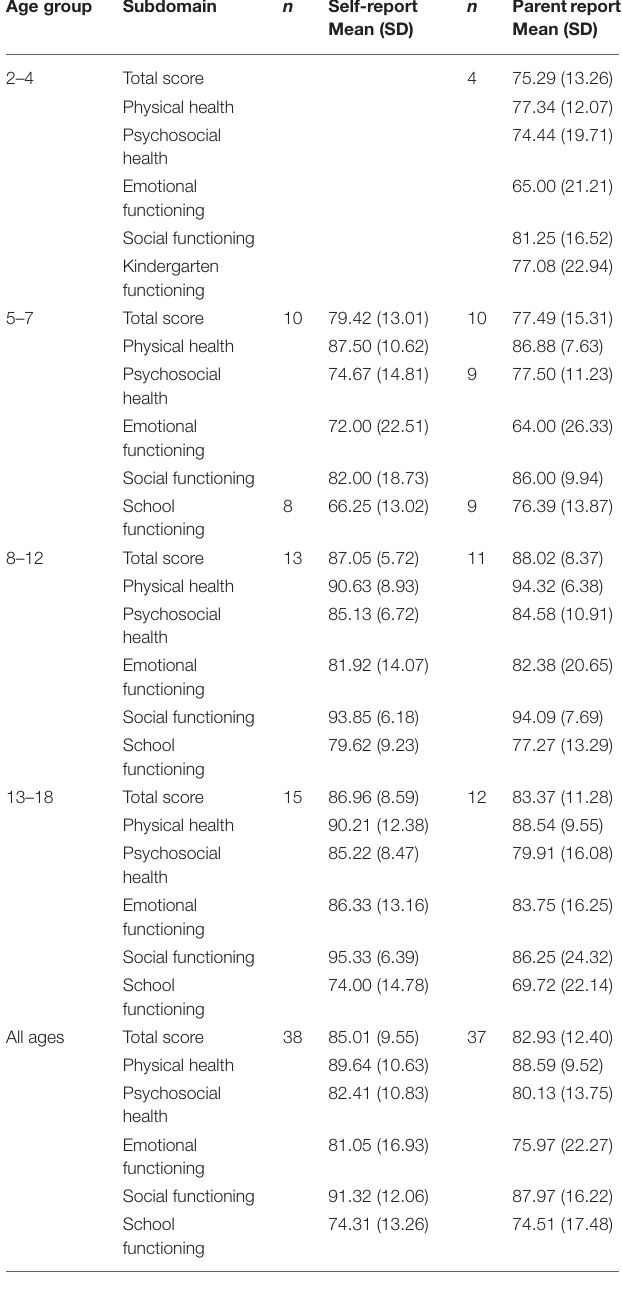
TABLE 6 | Pediatric quality-of-life inventory, parental and self-reports. Age